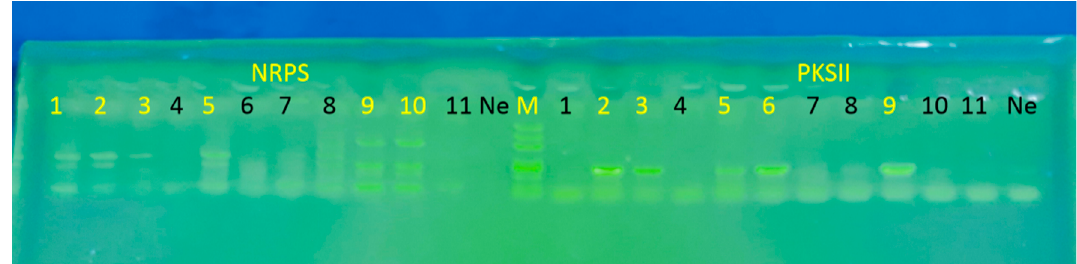
Figure 4. Non-ribosomal peptide synthetases (NRPS) and Polyketide synthases type II (PKSII) holder isolates. Left to right NRPS lane 1 to lane 11 (HM2, HM5, HM6, HM8, HM9, HM12, HM19, HM20, HM21, HM22, and HM23) and Ne (negative control for NRPS); M (marker); and left to right PKSII lane 1 to lane 11 (HM2, HM5, HM6, HM8, HM9, HM12, HM19, HM20, HM21, HM22, and HM23) and Ne (negative control for PKSII).